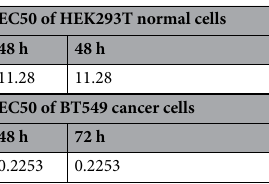
Table 1. EC50 values of HEK293T and BT549 cells after treatment with SA hydrogel/SF/HNTs/Fe 3 O 4 nanobiocomposite after 48 h and 72 h.